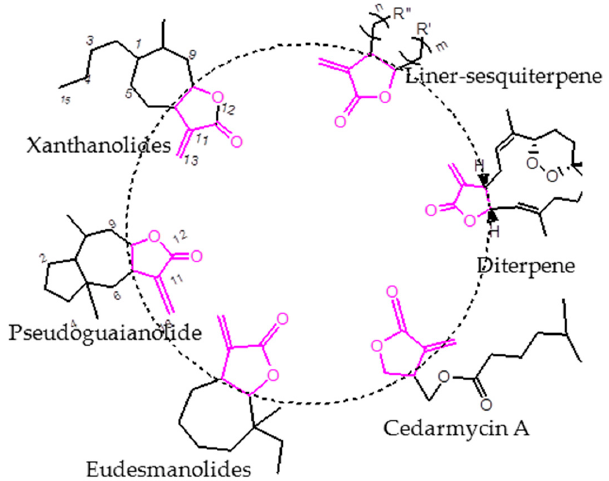
Figure 1. Some representative sesquiterpenoid structures.